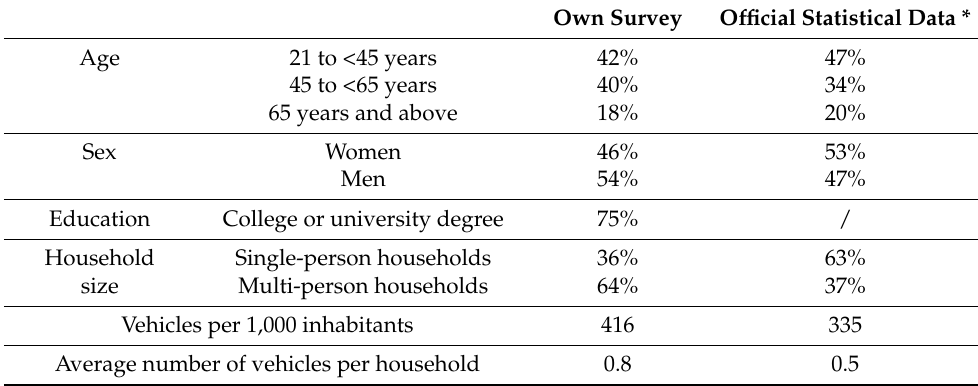
Table 2. District of Hoheluft-Ost: sample characteristics compared to official statistical data. Own Survey Official Statistical Data * 21 to <45